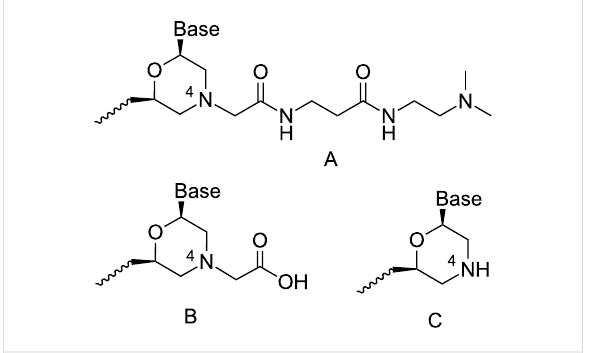
Figure 2: Dangling residues of MorGly oligomers synthesized by solid phase supported (A) and liquid phase synthesis (B); the blunt end of MorGly oligomer